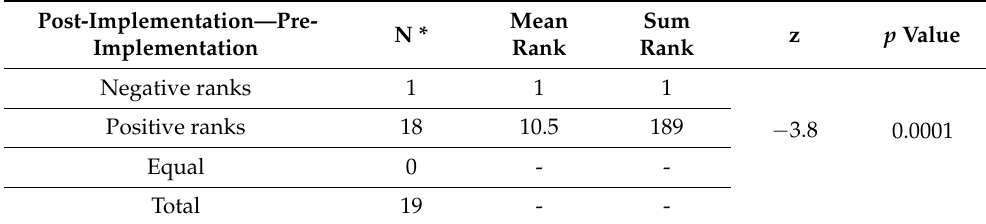
Table 5. Wilcoxon signed rank test results of students’ GPA pre- and post-implementation of the